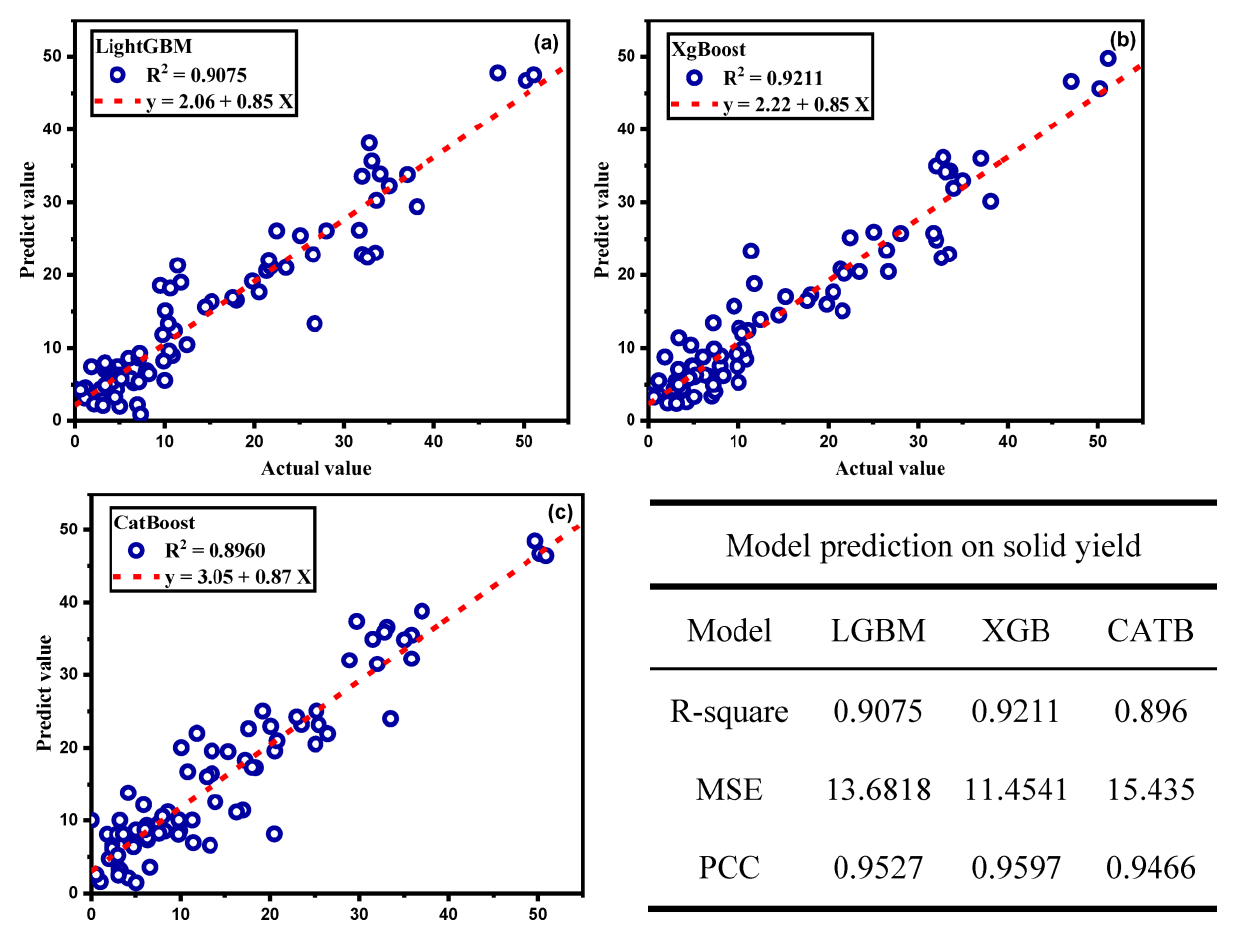
Figure 2. Solid yield prediction curve and prediction score of ( a ) LightGBM, ( b ) XgBoost, ( c ) CatBoost and table of machine learning evaluation results.